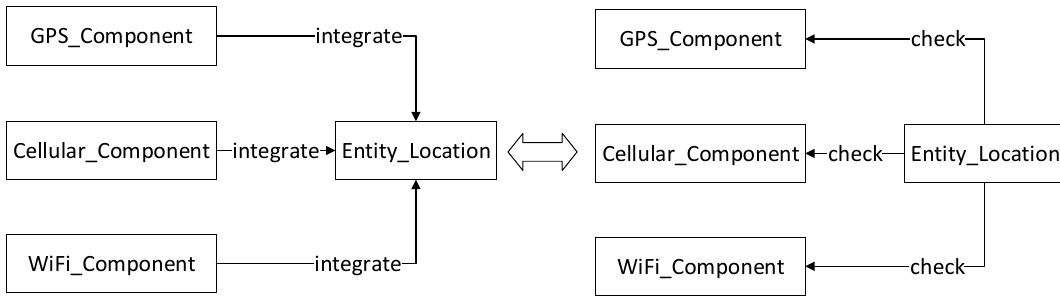
Figure 3. The hybrid localization solution as a semantic match